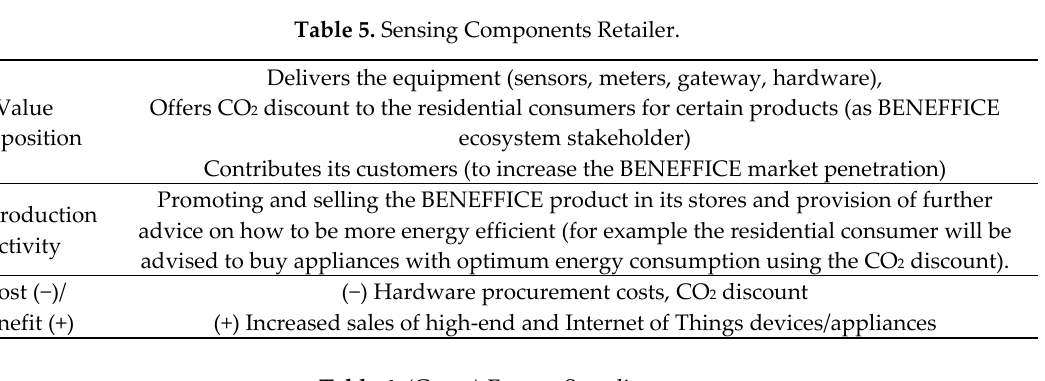
Table 6. (Green) Energy Supplier.